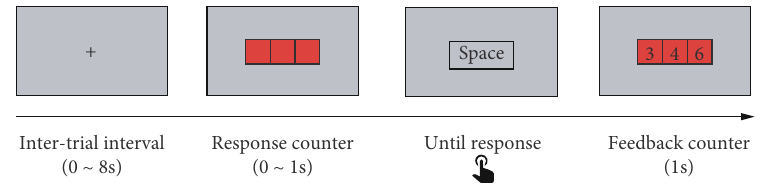
Figure 1: Schematic illustration of one trial in Experiment